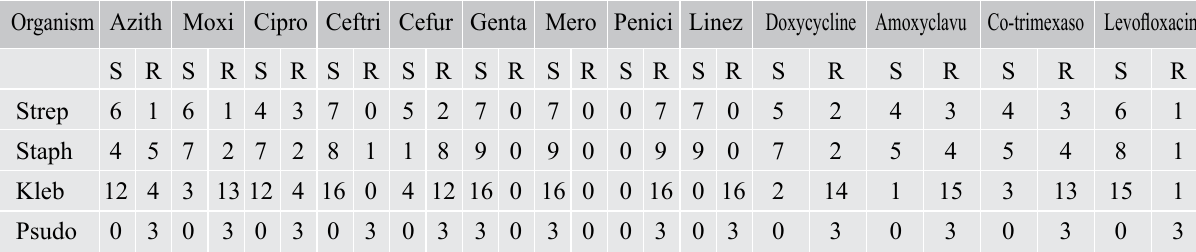
Table III: Sensitivity pattern of isolated